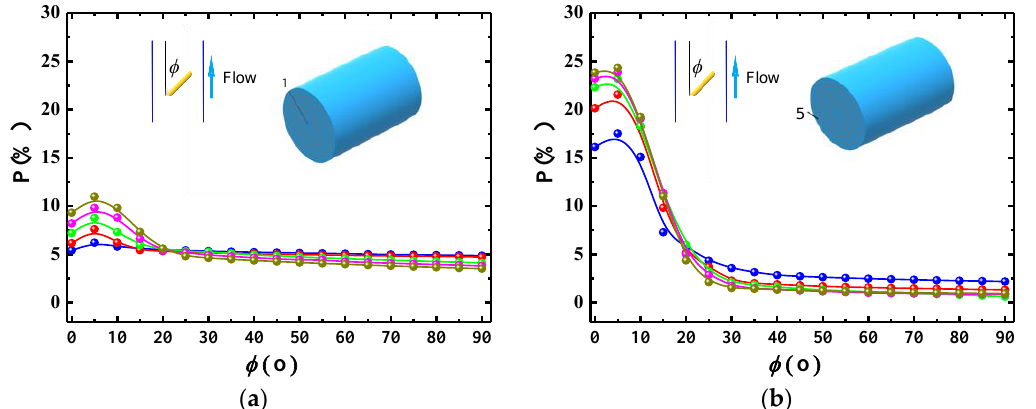
Figure 7. Distribution of mean particle orientation in region 1 and 5 for different particle aspect ratio (Re = 20,000, L/D = 200). ( a ) Region 1 and ( b ) region 5. • : λ = 2; • : λ = 4; • : λ = 8; • : λ = 12; • : λ = 16.